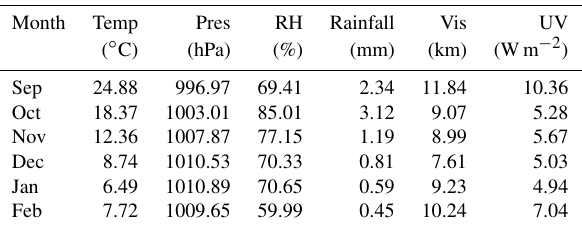
Table 2. Statistics of general meteorological parameters at the Gu- lou site during the study